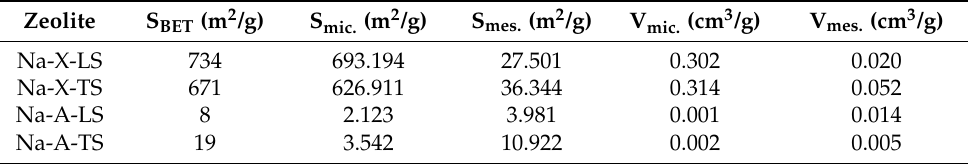
Table 4. Textural parameters of obtained